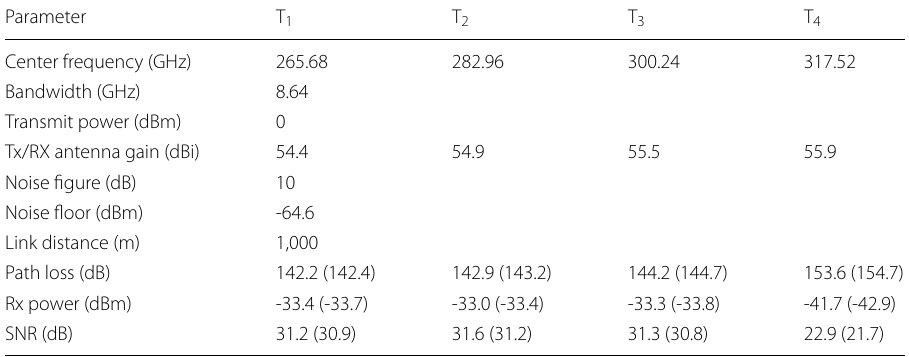
Table 2 Link budget calculations for the THz band channels. Values in brackets are the exact theoretical